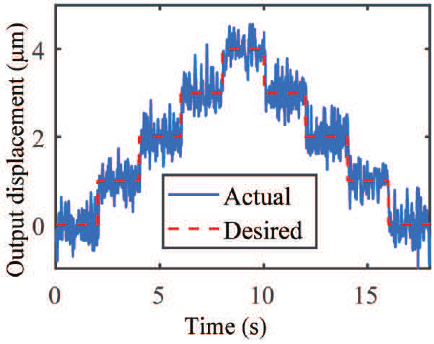
Figure 16. Experimental result of motion resolution test of the microgripper jaw.